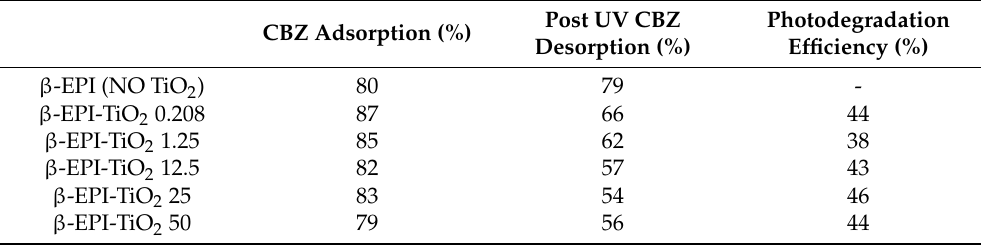
Table 1. Comparison of efficiencies of CBX (5 mg/L) adsorption onto β -EPI and β -EPI-TiO 2 (25 g/L) at different amounts of photocatalyst and efficiencies of CBX photodegradation on solid state. Post UV CBZ Adsorption (%)